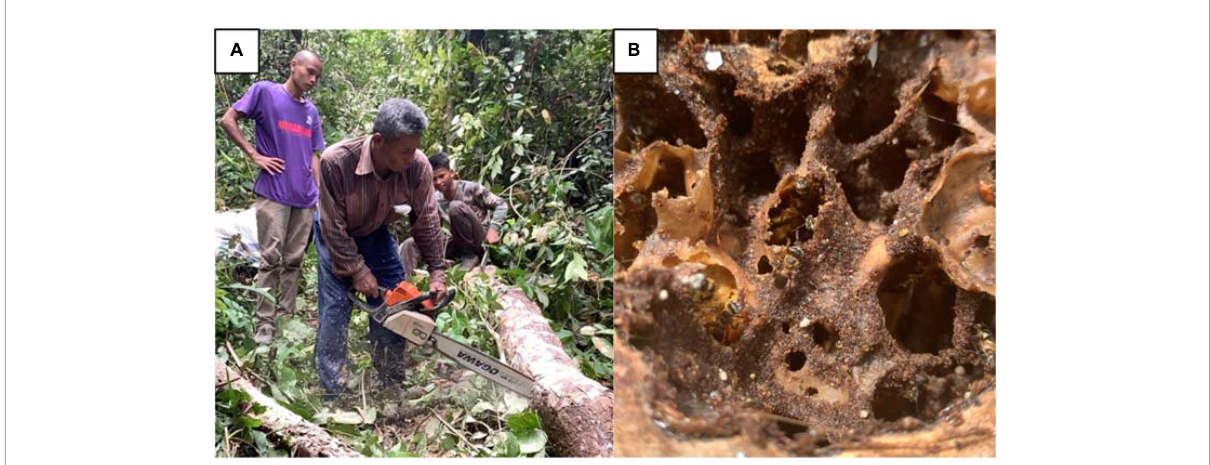
FIGURE7 (A) A. Embong with his children cutting the hollow tree where the stingless bee’s nest is (A) , and the stingless bees inside their nest (B) . Source: Photographed by the first author in Hulu Langat, Selangor, Malaysia, on 23 November